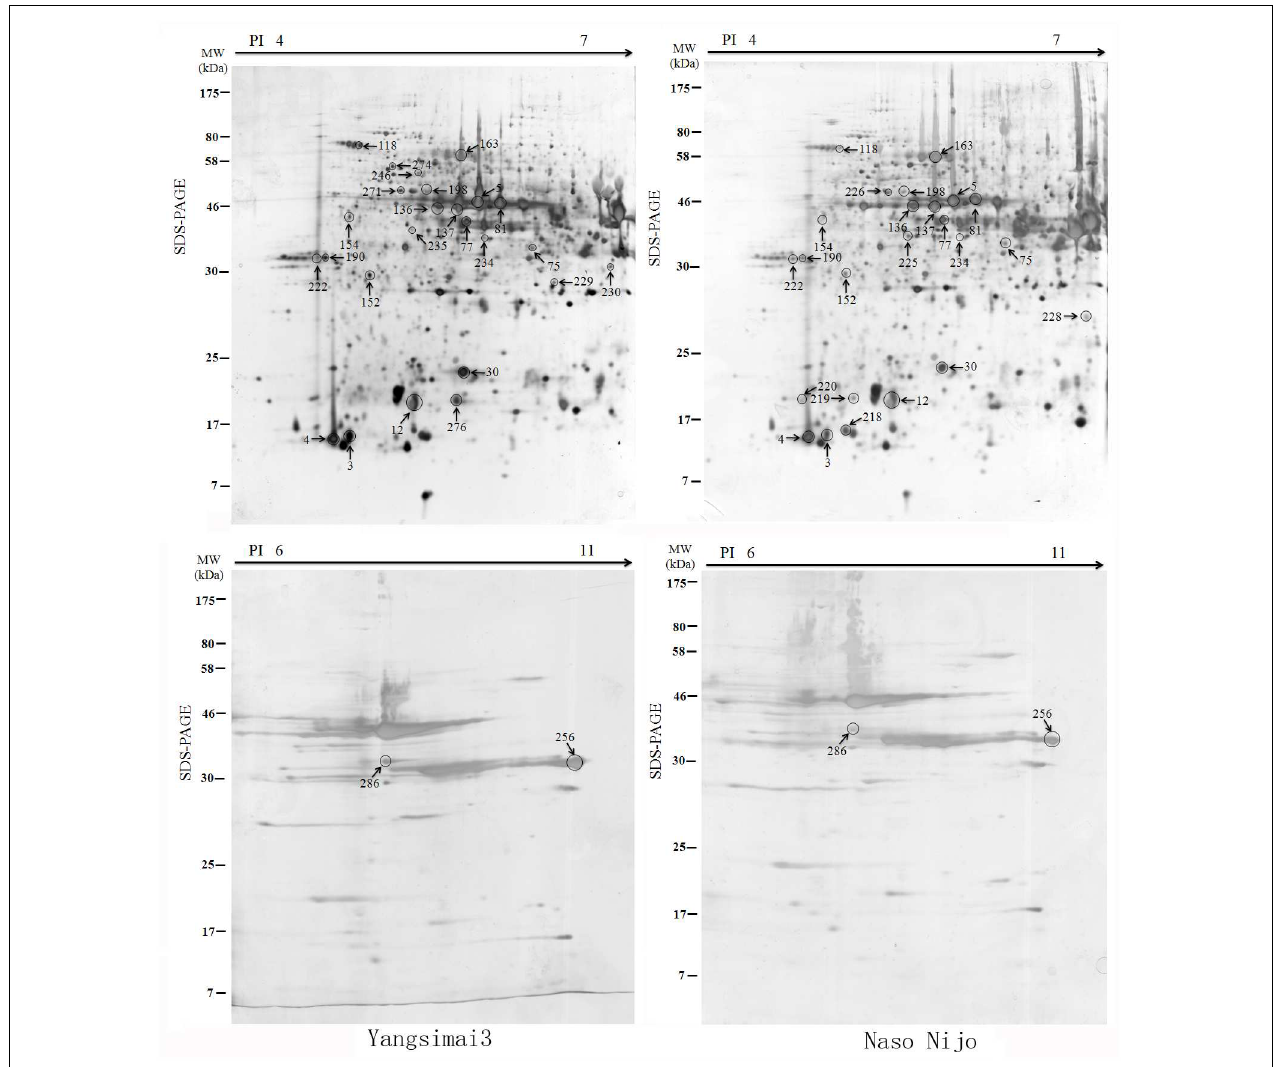
FIGURE 2 | The differentially expressed protein profiling between Yangsimai 3 and Naso